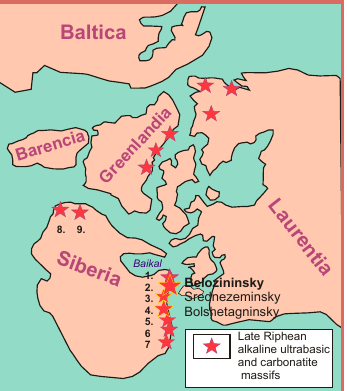
Figure 2. Paleo reconstruction for the Vendian (Neoproterozoic III) time of the Northern continents [16–19]. Carbonatite massifs: 1—Zhidoysky; 2—Beloziminsky; 3—Sredneziminsky; 4—Bolshetagninsky; 5—Arbarastakh; 6—Srednetatarsky; 7—Tatarsky; 8—Ingili; 9—Kiysky (redrawn from [10] with the